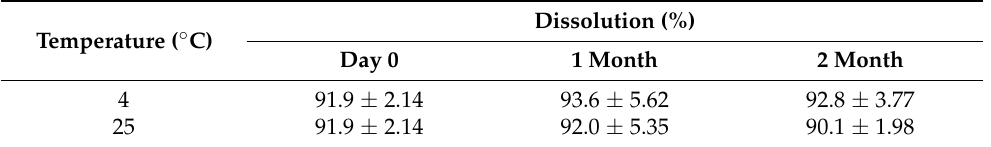
Table 2. Storage stability of LSD-F3 at 4 °C and 25 °C (Mean ± SD, n = 3).